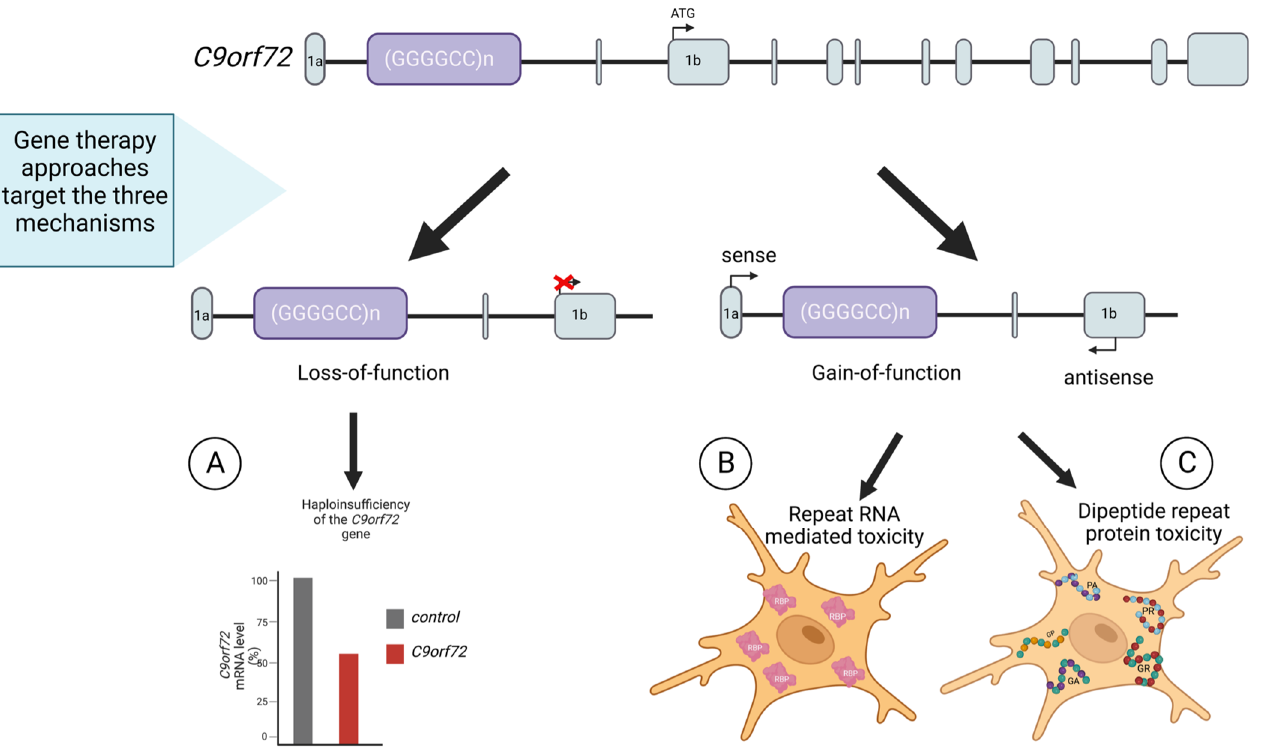
Figure 2. Pathomechanisms of C9orf72 -associated ALS. ( A ) HRE can inhibit the transcription of C9orf72, resulting in loss of function. ( B ) Expansion can also be transcribed bidirectionally in either sense or antisense transcripts, which accumulate in RNA foci sequestering RNA-binding proteins (RBPs). ( C ) The HRE can be translated through a repeat-associated AUG-independent (RAN) translation mechanism producing toxic dipeptides (DPRs) generated from both the sense and antisense reading frames. Five DPRs have been described: glycine-alanine (GA), glycine-arginine (GR), proline-alanine (PA), proline-arginine (PR) and glycine-proline (GP).